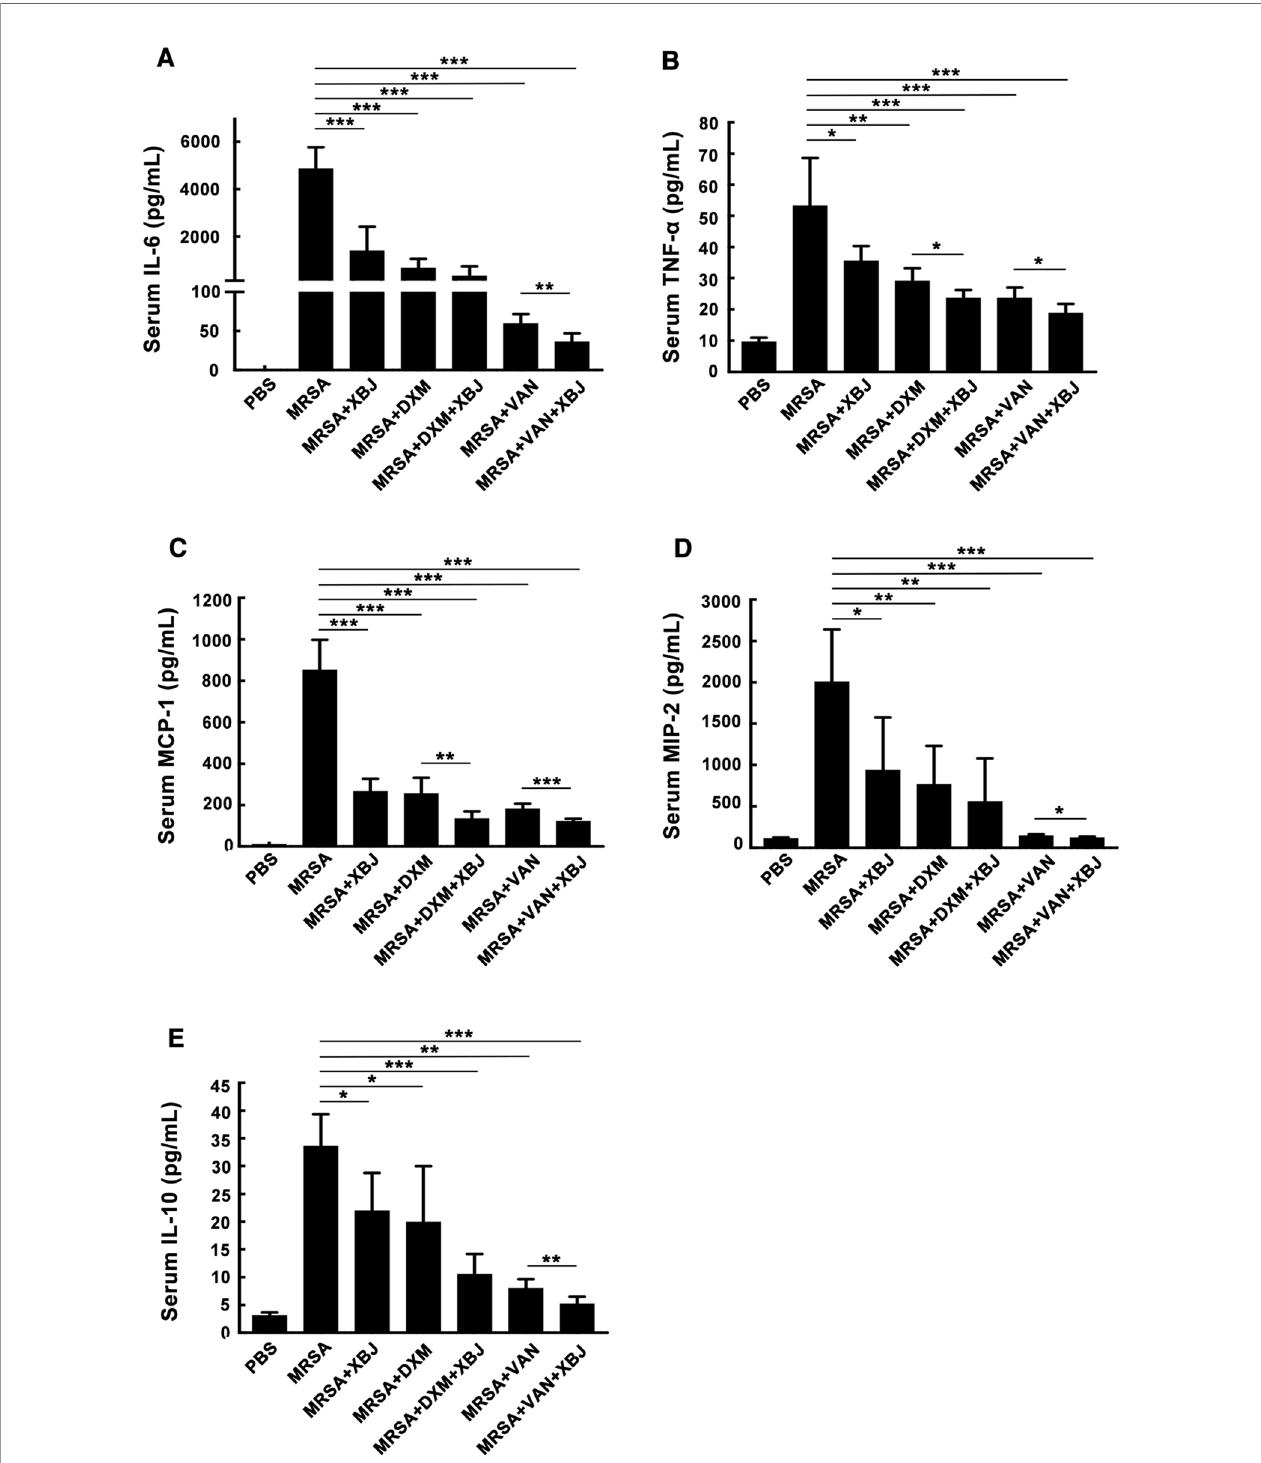
FIGURE 3 | XBJ decreased the in fl ammatory response in MRSA-infected mice. C57BL/6J female mice were randomly divided into seven groups (N=6/group). All groups of mice were intraperitoneally injected with MRSA (4 × 10 8 CFU/mouse) and XBJ (5 ml/kg), DXM (7 mg/kg), VAN (110 mg/kg), and their combination in corresponding groups. After 12 hours, blood samples were collected from eyeball, standing still at 4 ℃ for 3 hours, and then centrifuged for 25 minutes (3500 rpm, 4°C) to obtain sera. The concentrations of IL-6 (A) , TNF- a (B) , MCP-1 (C) , MIP-2 (D) ) and IL-10 (E) were detected by ELISA. Data were shown as mean ± SD of six mice per group. * , ** , ***Signi fi cantly different at p < 0.05, p < 0.01, and p < 0.001,